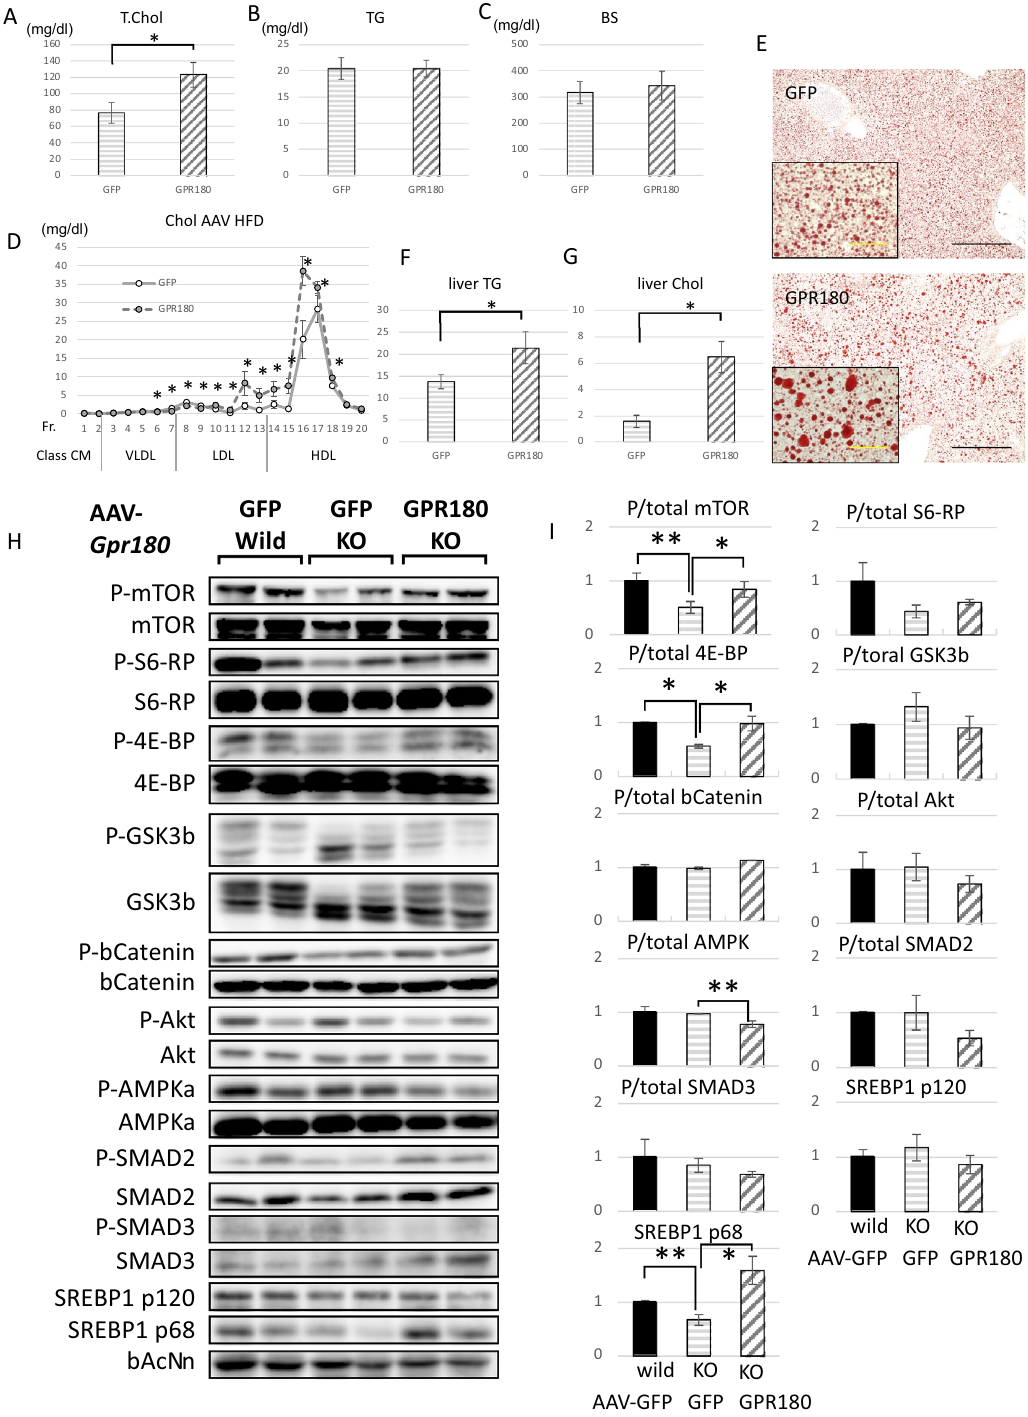
Figure 5. AAV-mediated hepatic rescue of GPR180 expression in KO mice. ( A ) Plasma total cholesterol, ( B ) TG and ( C ) blood glucose of AAV8-CAG-GFP or AAV8-CAG-GPR180 injected KO mice fed HFD after 6 h starvation (n = 6). ( D ) Cholesterol levels in HPLC-fractionated plasma of AAV8-CAG-GFP or AAV8-CAG- GPR180 injected KO mice fed HFD (n = 4). ( E ) Representative Oil Red O staining of 16-week-old mouse liver fed HFD. Black and yellow scale bars indicate 100 and 20 μm, respectively. ( F ) TG and ( G ) cholesterol contents in liver extract (mg/g) of AAV8-CAG-GFP or AAV8-CAG-GPR180 injected KO mice fed HFD (n = 6). ( H ) Twenty micrograms of protein per sample of AAV8-CAG-GFP injected wild-type liver, AAV8-CAG-GFP or AAV8-CAG-GPR180 injected KO mouse liver were stained with the primary antibodies indicated on the left and HRP-labeled secondary antibody. ( I ) Relative band intensities against the normalized mean value of wild- type mice are shown as mean values with standard deviation (n = 6). *p < 0.05. **p <